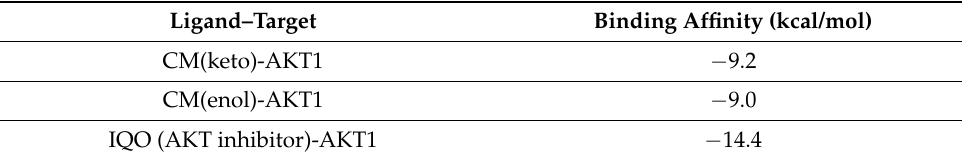
Table 3. Ligand–target binding affinity, compared to AKT inhibitor IQO.